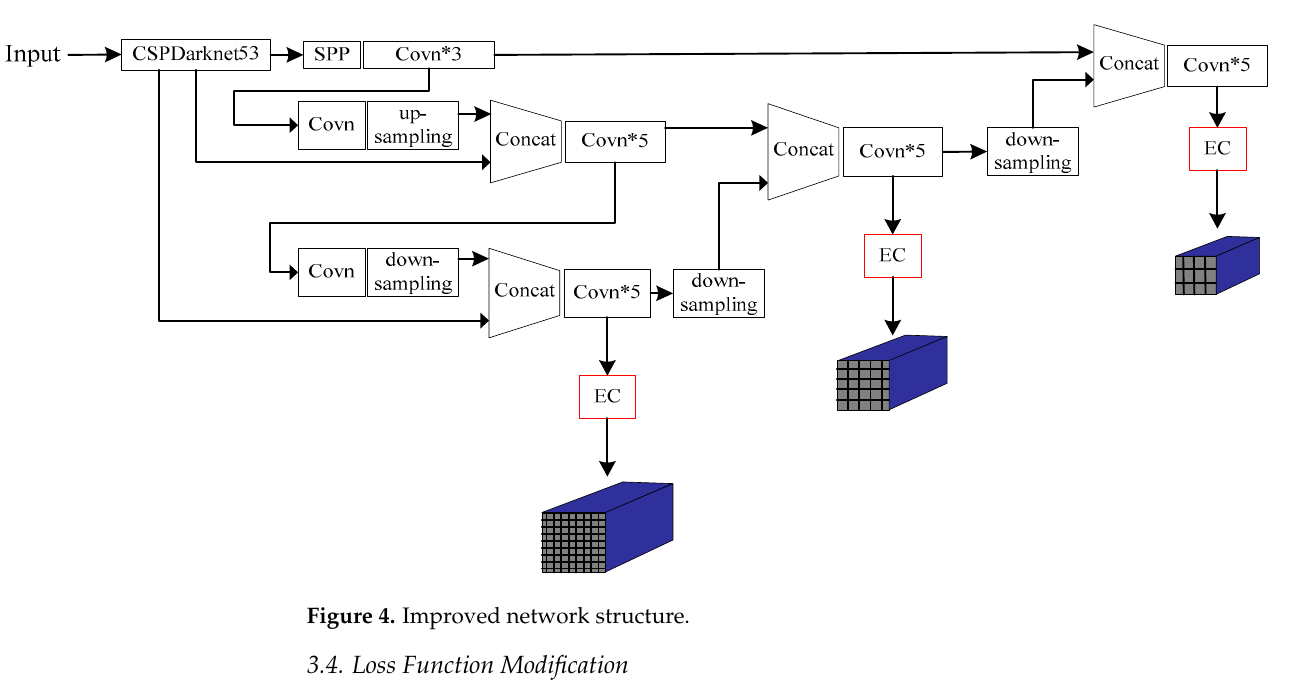
7 of 16 Figure 3. EC component. ( a ) structure of EC; ( b ) Convolution 1; ( c ) Convolution 2.